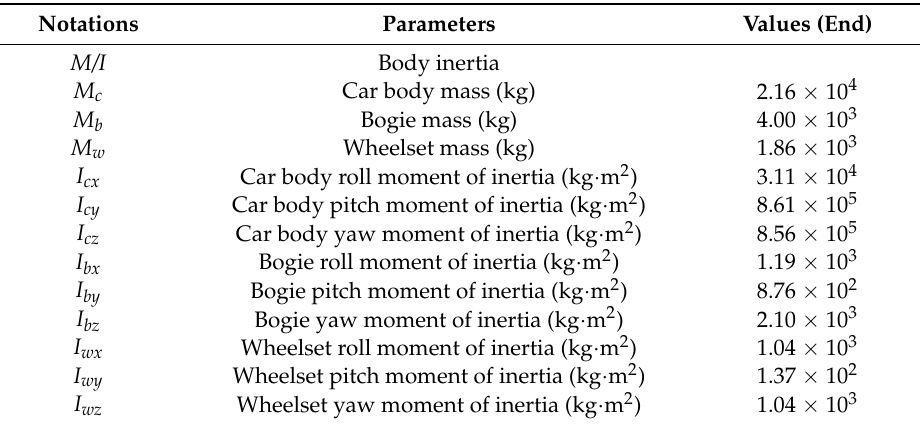
Table 1. Main parameters of metro